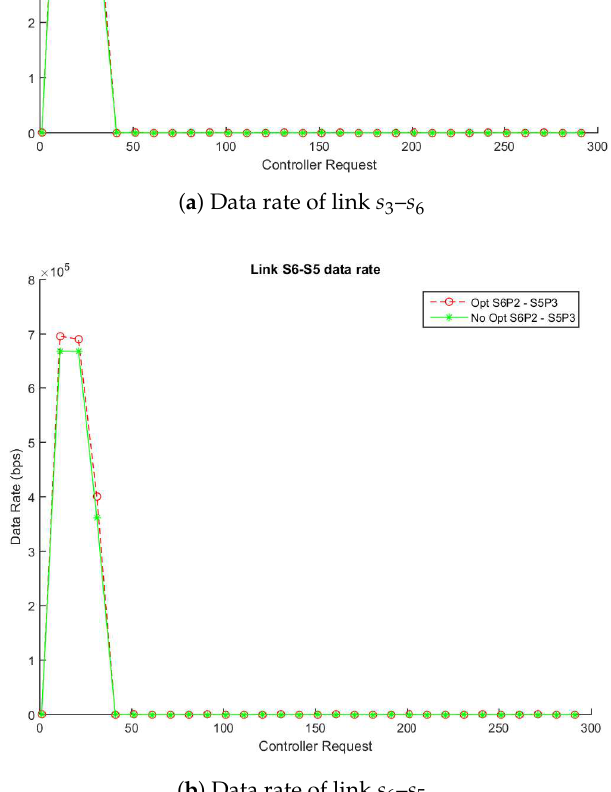
Figure 4. Enhanced vs. Non-Enhanced Data and Error Rate of